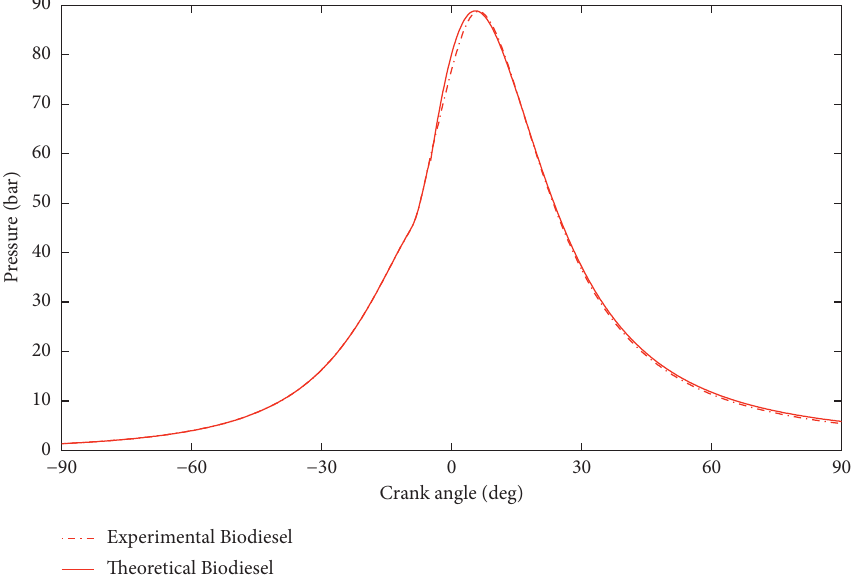
Figure 4: Comparison of experimental and theoretical pressures for biodiesel